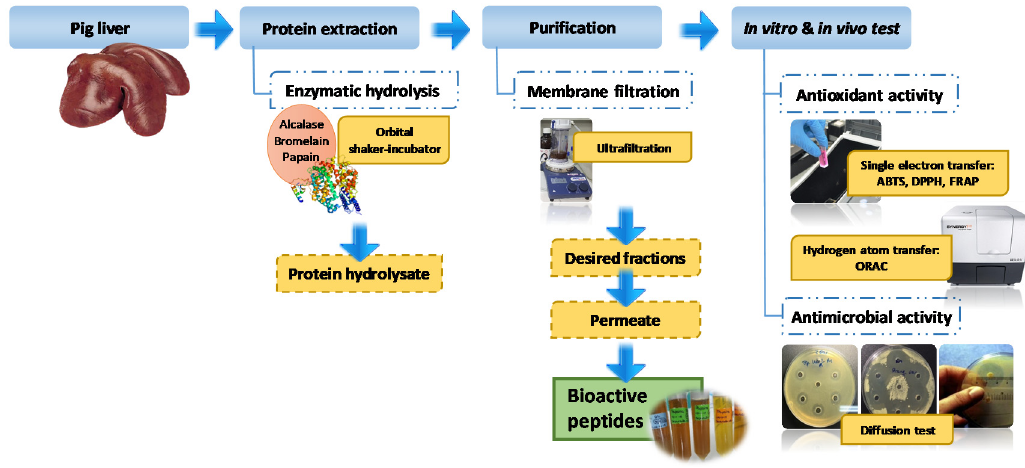
Figure 1. Process of obtaining protein hydrolysates from porcine liver. DPPH: 2,2-Diphenyl-1- picrylhydrazyl Radical Scavenging Activity; ABTS: 2-2 ′ -Azino-di-[3-ethylbenzthiazoline sulfonate] Radical Scavenging Activity; FRAP: Ferric Reducing Antioxidant Power; ORAC: Oxygen Radical Absorbance Capacity.